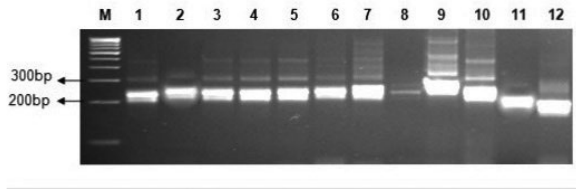
Figure 4. Gel image showing Bulked sample analysis with DNA pools generated with TA144, M: 100bp Banglore Genei ladder, 1:ILWC292,2:GL1001, 3:PAU7007, 4:PAU7014, 5:GLW91, 6: C. juda- icum ILWC223, 7: GLW22, 8: GLW25, 9: PBG7, 10: GLW69, 11: Resistant bulk, 12: Susceptible bulk.